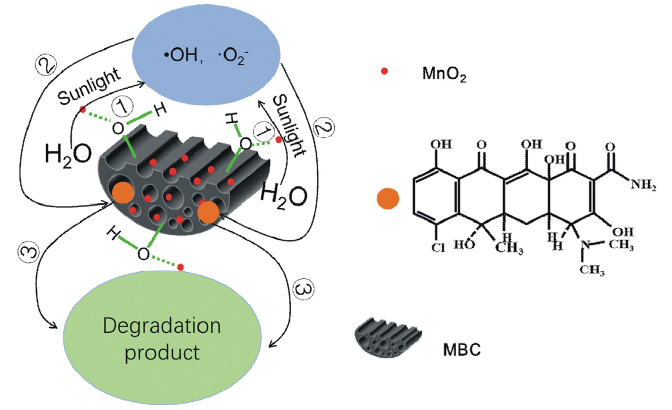
Figure 7. Schematic diagram of CTC degradation process by SSM.